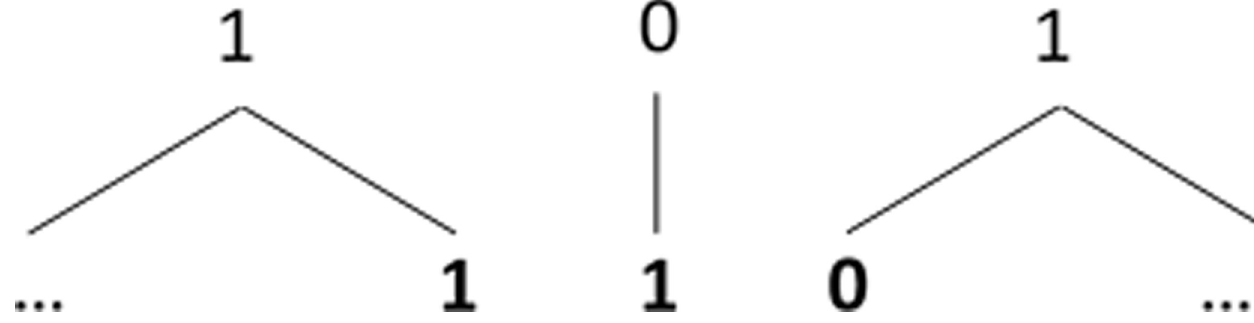
Fig 8. Representation of the trigram [110] in